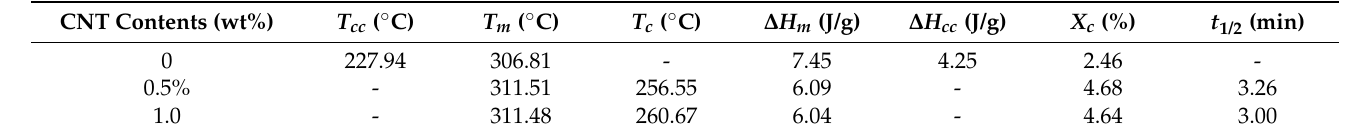
Figure 10. The DSC second heating curves of composites with different CNT contents.